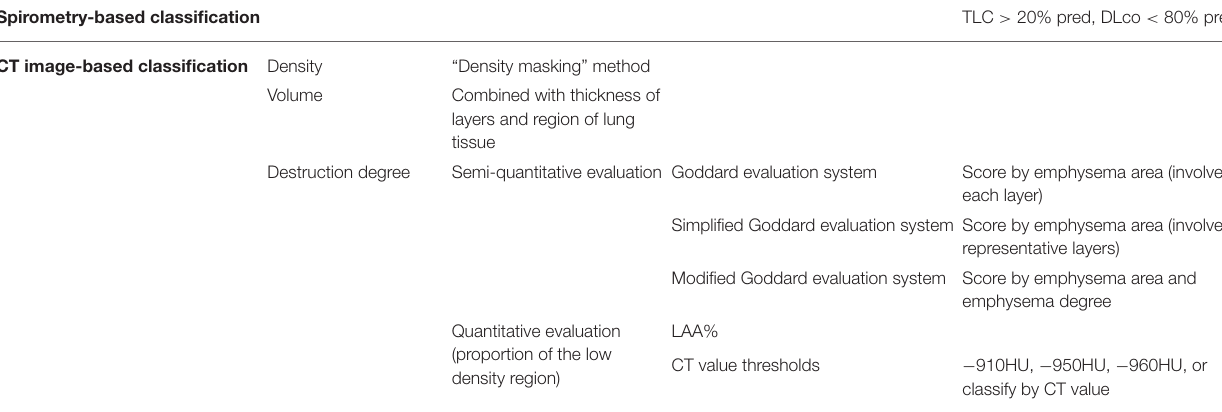
TABLE 1 | Analysis methods of emphysematous phenotype judgement. Spirometry-based